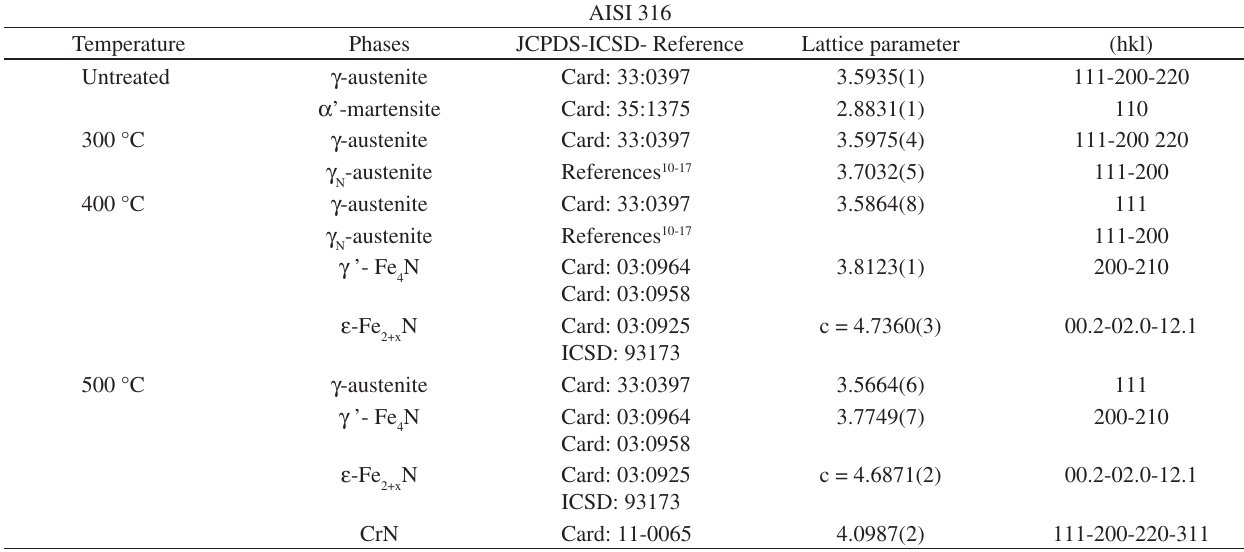
Table 2. Phases, lattice parameters, space group and symmetry for untreated and nitrided AISI